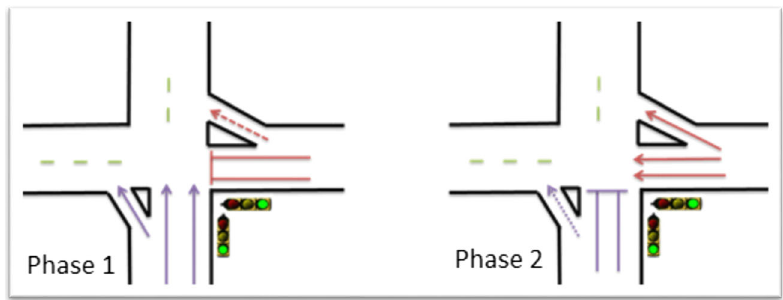
Fig. 1 Phases of the intersection